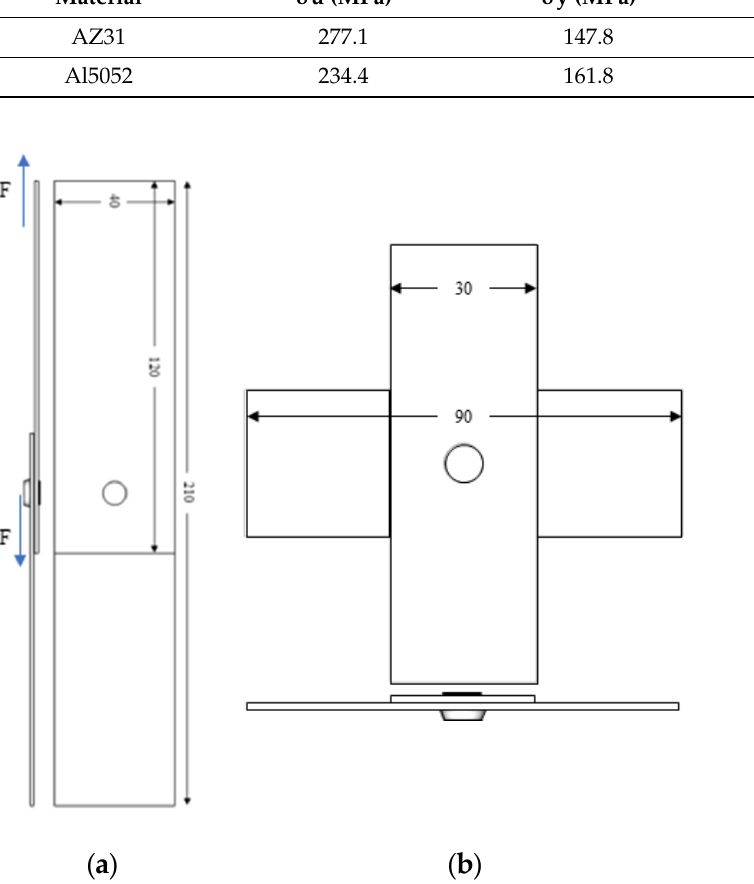
Figure 2. Geometries and dimensions of the ( a ) tensile-shear and ( b ) cross-shaped specimens (mm).